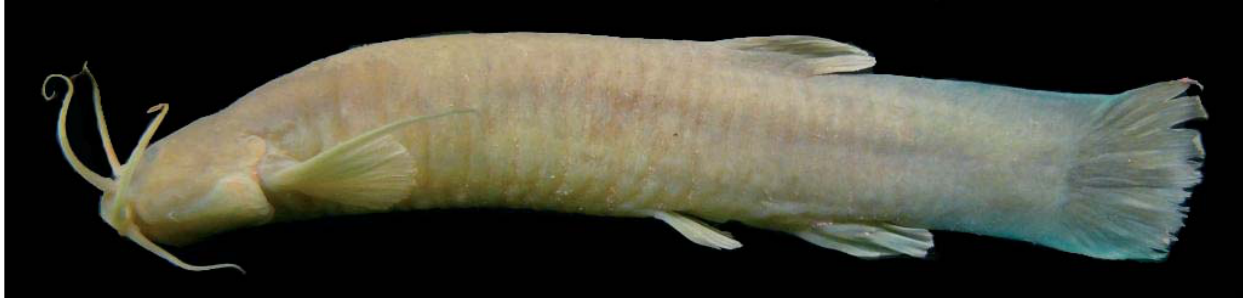
Fig. 2. Trichomycterus uisae , holotype, CAC-CDMB 72.5 mm SL. Cueva El Misterio, upper Sogamoso River basin, Santander, Colombia. Lateral view of the left